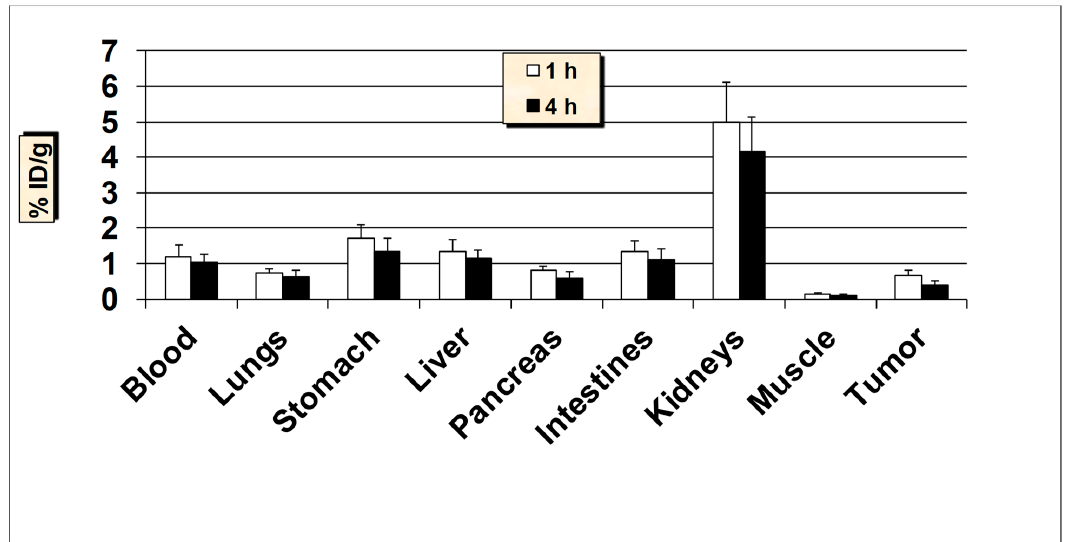
Figure 14. In vivo tumor targeting of 99m Tc-MUC1-derived peptide in MUC1-negative MDA-MB-231 tumor bearing female nude mice at 1 and 4 h post-injection. Data are expressed as % injected dose per gram (% ID / g) of tissue / organ (n = 3, mean values ± SD). Parts of the intestines were measured without their